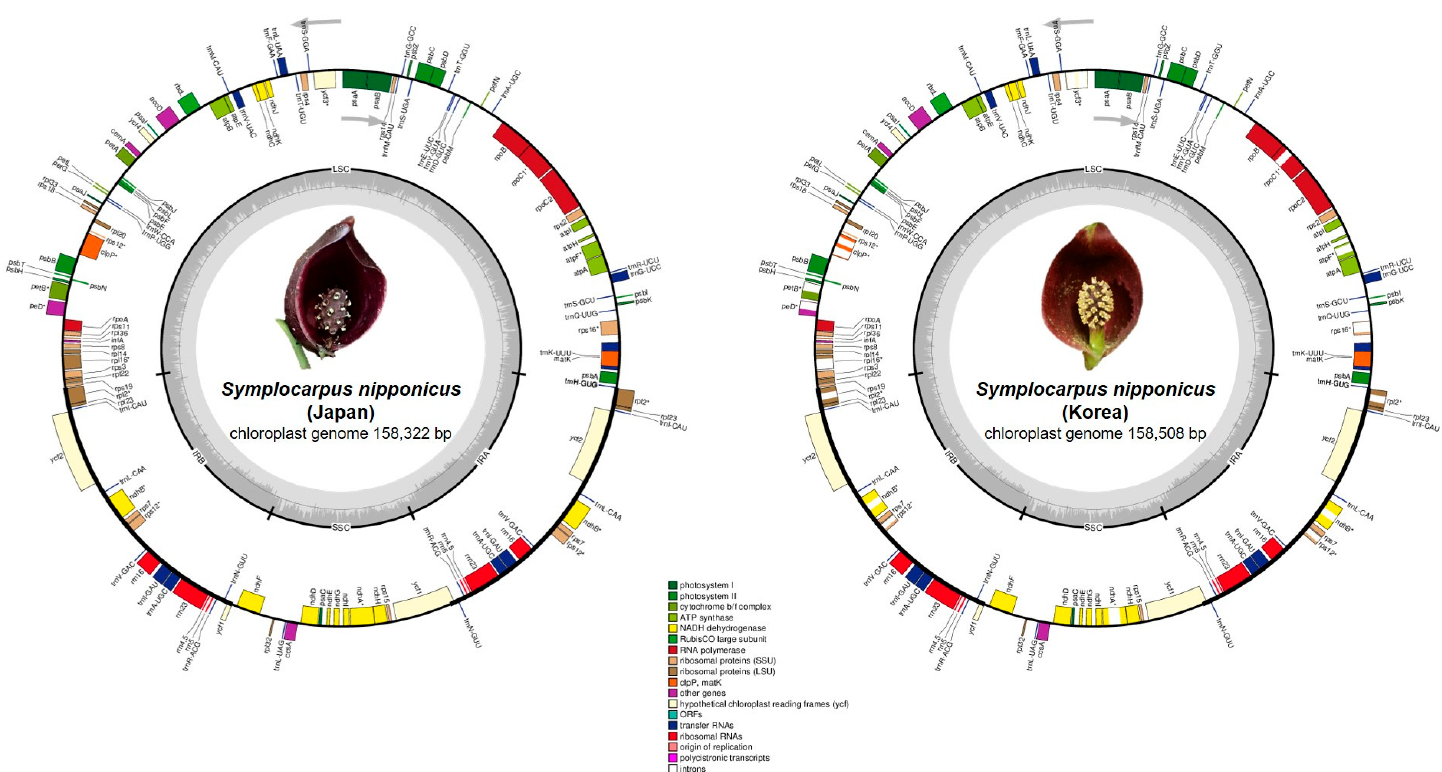
Figure 1. Complete plastome map of Symplocarpus nipponicus sampled from Korea and Japan. The genes inside and outside of the circle are transcribed in the clockwise and counterclockwise direction, repectively. Genes belonging to differenct functional groups are shown in different colors. The thick lines indicate the extent of the interted repeats (IR A and IR B ) that separate the genomes into small single copy (SSC) and large single copy (LSC) regions.